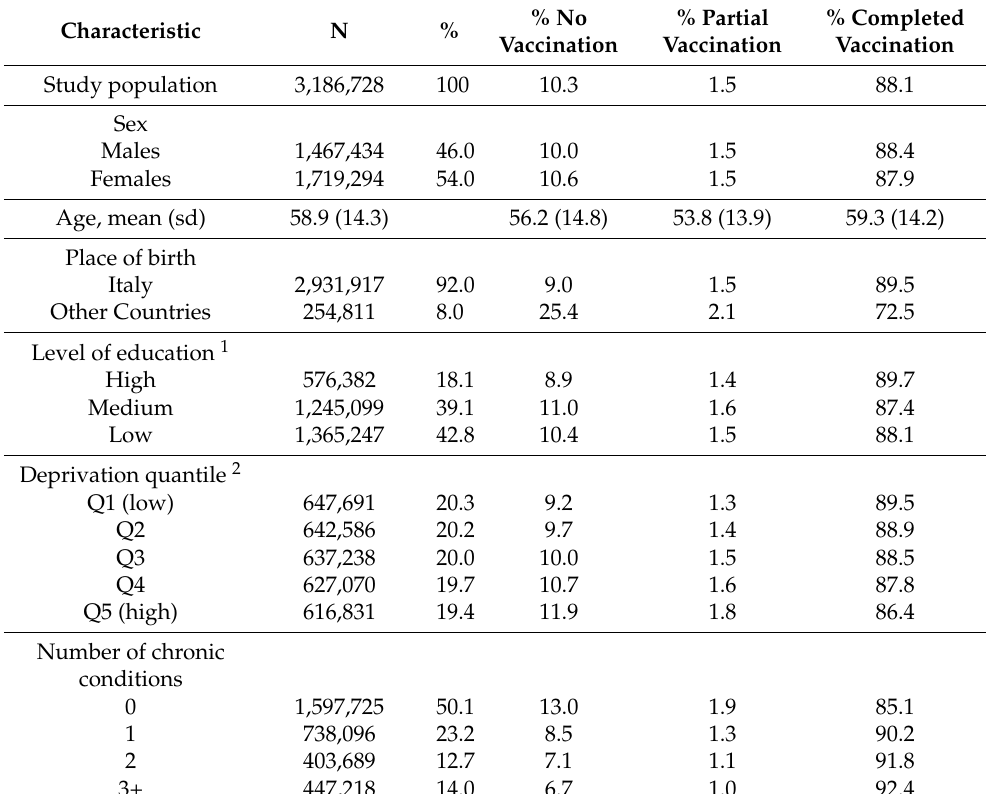
% No % Partial % Completed Vaccination Vaccination Vaccination